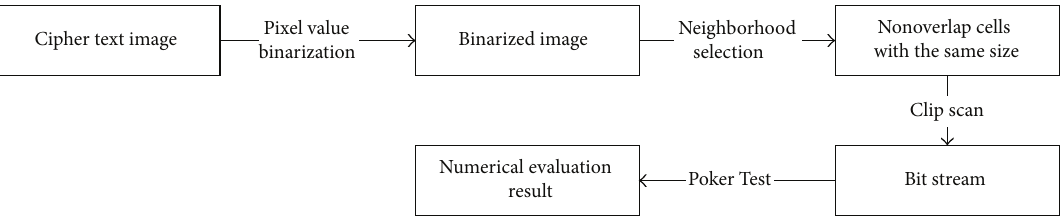
Figure 1: Flowchart of encryption performance evaluation of proposed